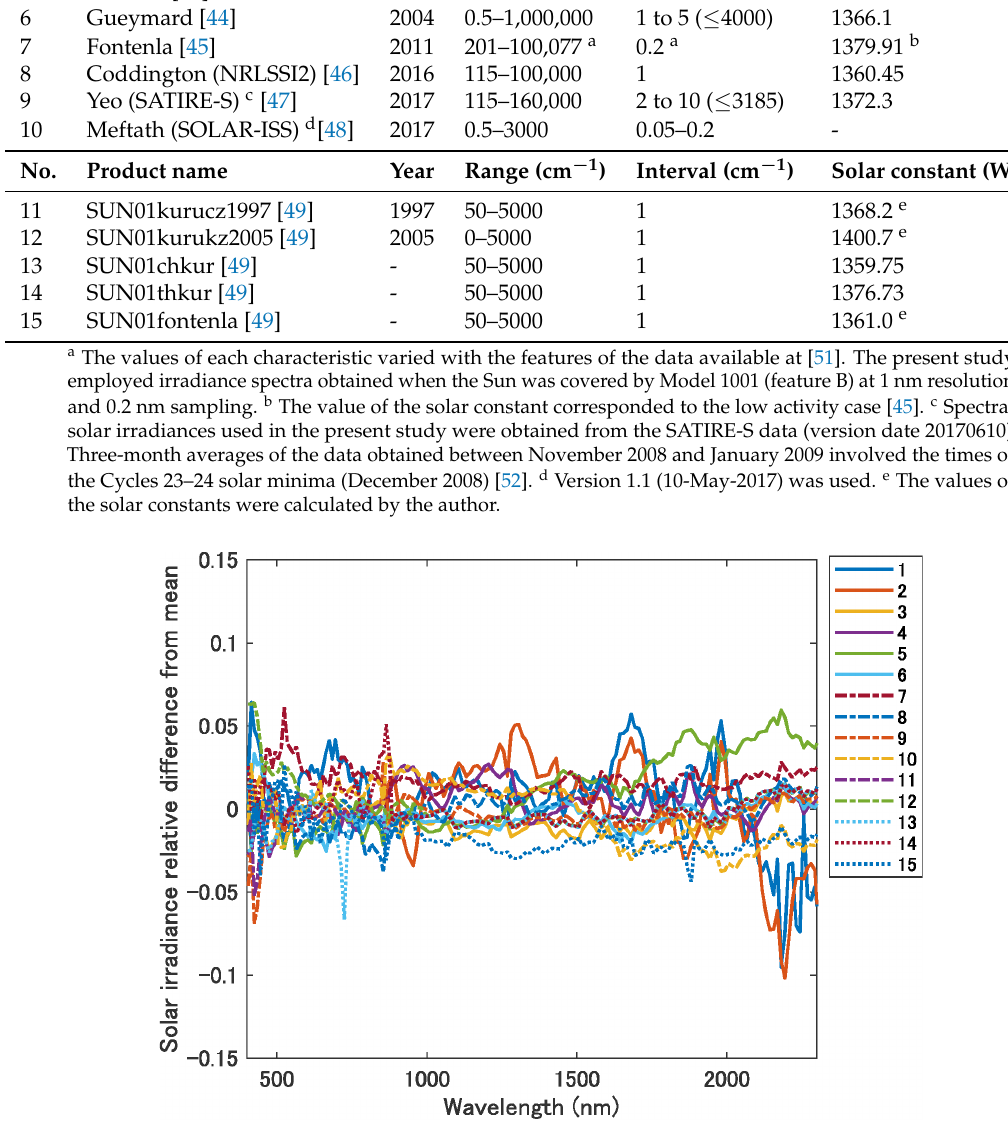
Figure 2. Relative differences between the 15 solar irradiances listed in Table 2 and their mean (each irradiance minus